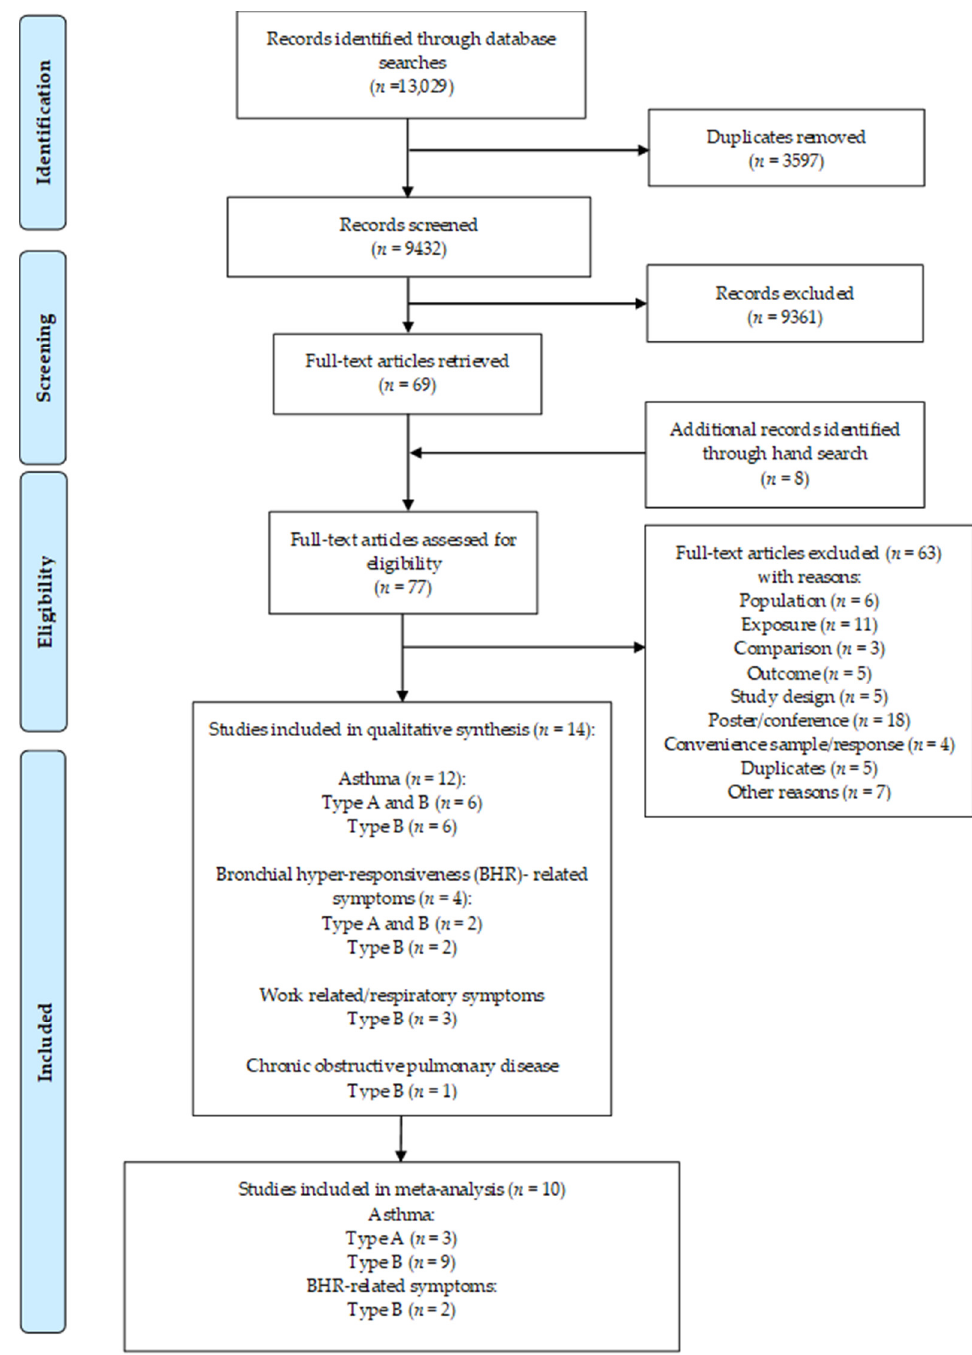
Figure 2. PRISMA Flowchart.